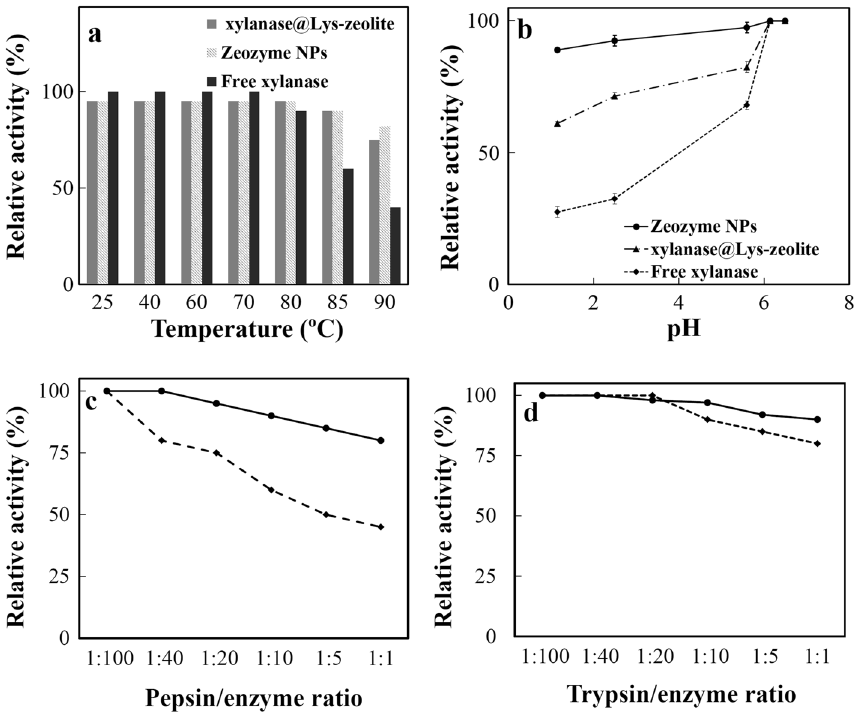
Figure 6. ( a ) The thermal, and (b) pH stability comparison between free xylanase, xylanase@Lys-zeolite, and Zeozyme NPs. Resistance evaluation of xylanase (dotted lines) and Zeozyme NPs (solid lines) to ( c ) pepsin at pH 2.0, and ( c ) trypsin at pH 7.0 at various pepsin or trypsin/enzyme ratios. All samples were incubated at 41 °C for 1